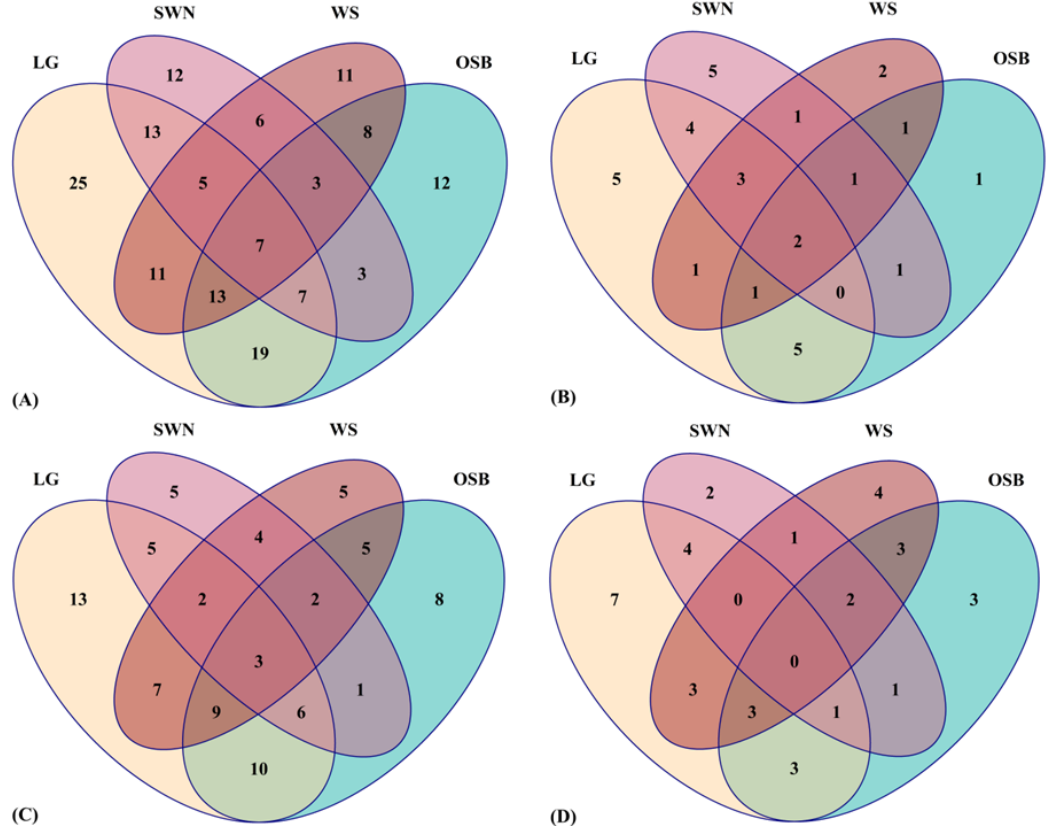
Figure 3. Distribution of phenolic compounds in Australian native plants. ( A ) a total number of phenolic metabolites, ( B ) a total number of phenolic acids, ( C ) a total number of flavonoids, ( D ) total other phenolic metabolites in Australian native lemongrass (LG), sandalwood nuts (SWN), wattle seeds (WS), and old man saltbush (OSB).